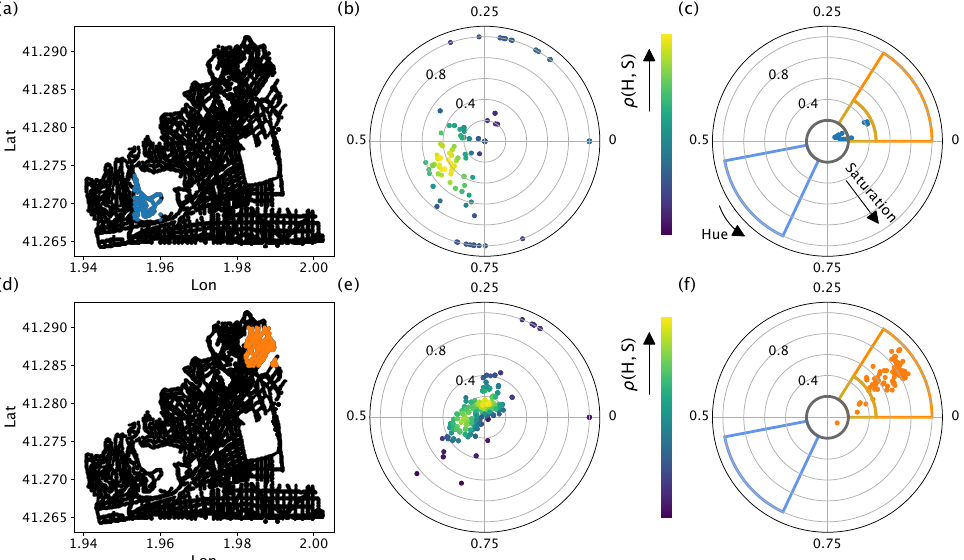
Figure 8. ( a ) Inventory of the streetlights of Castelldefels, distinguishing the HPS lamps (orange) from the other types (blue) ( b ) Colours of the streetlights according to the ISS data. ( c ) Colours of the streetlights according to the NightUp data (where available). Selected areas are marked by the white dashed line.